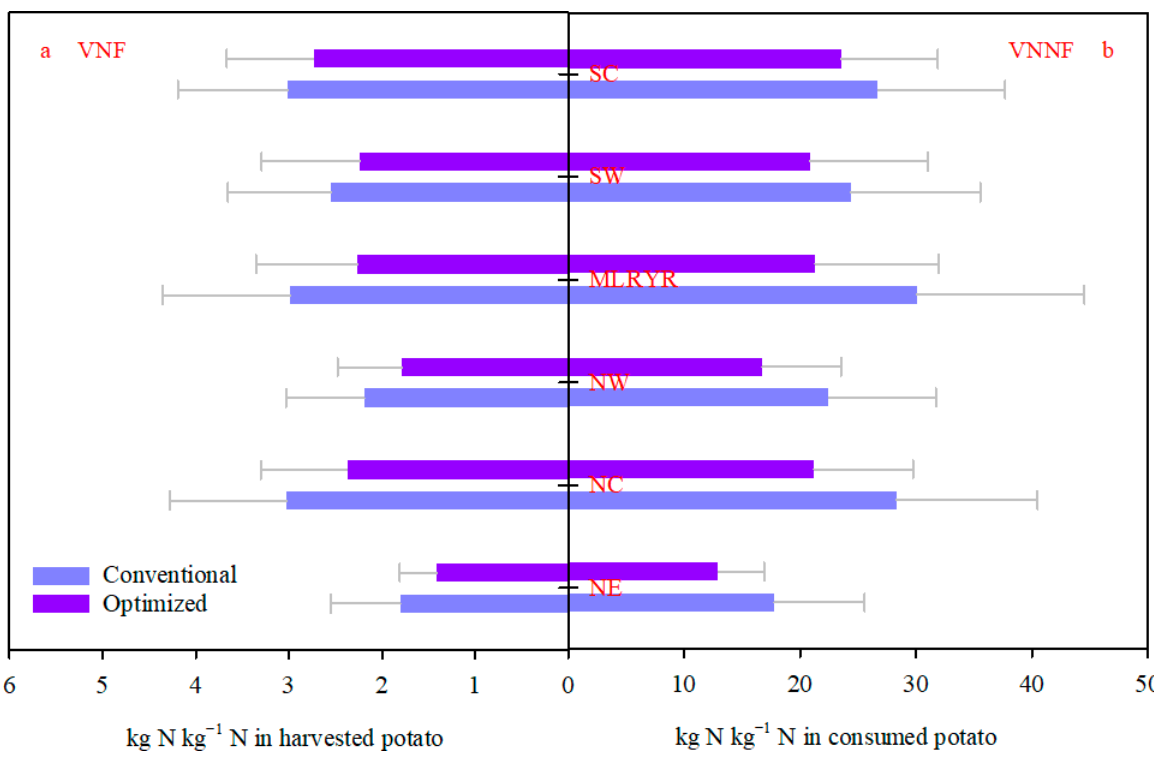
Figure 2. VNF ( a ) and VNNF ( b ) indicators of potatoes under conventional and optimized measures in the six cultivation regions.